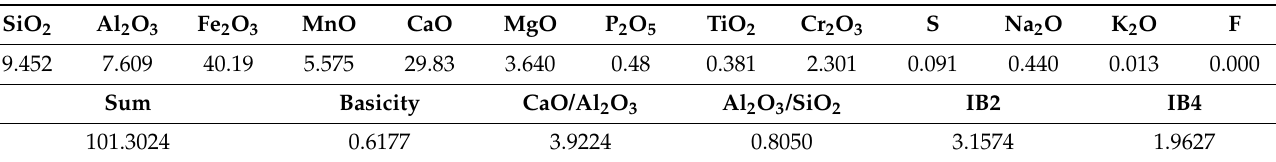
Table 1. EAF slag chemical composition (%) determined by X-ray fluorescence spectroscopy (XRF) basicity index IB2 = CaO/SiO 2 and basicity factor IB4 = (CaO + MgO)/(SiO 2 + Al 2 O 3 ). SiO